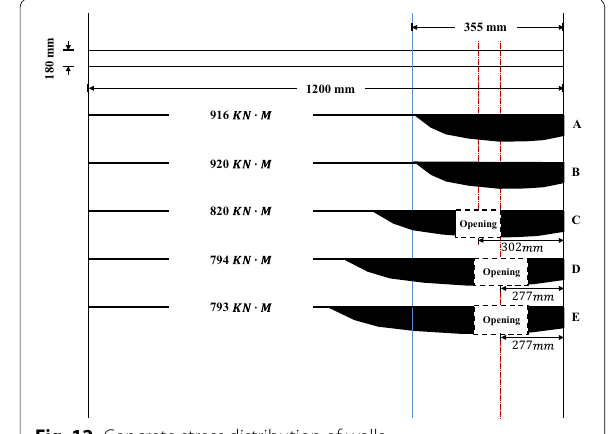
Fig. 12 Concrete stress distribution of